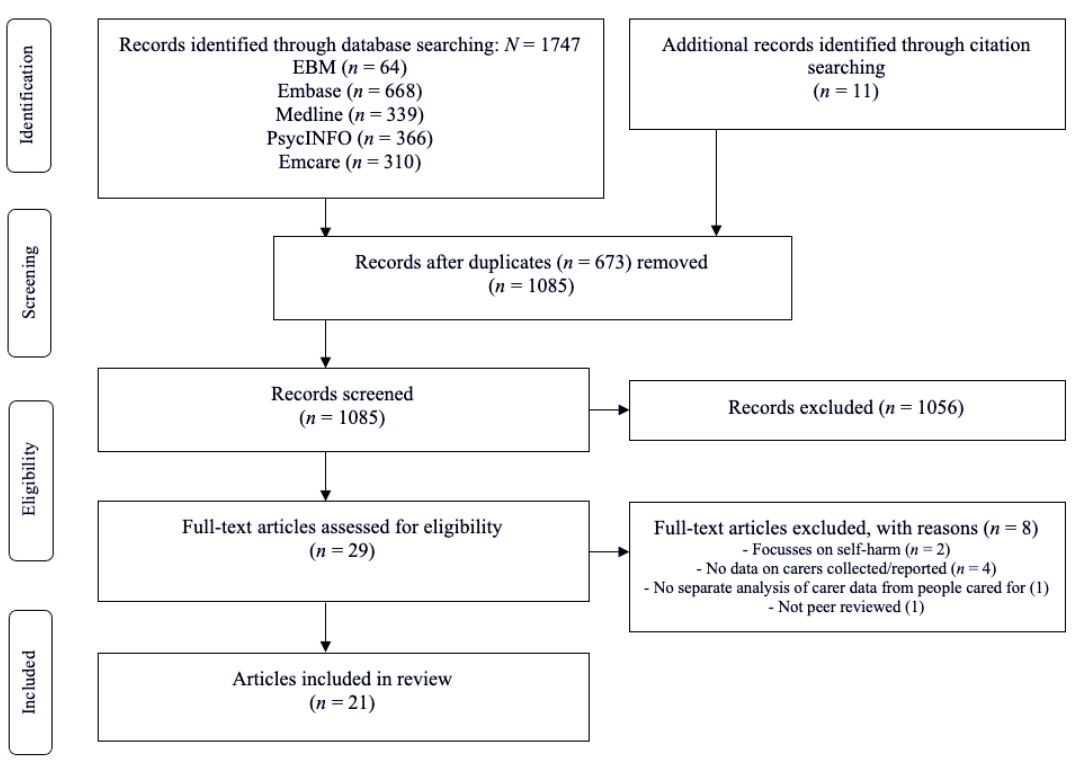
Figure 1. PRISMA flow diagram.